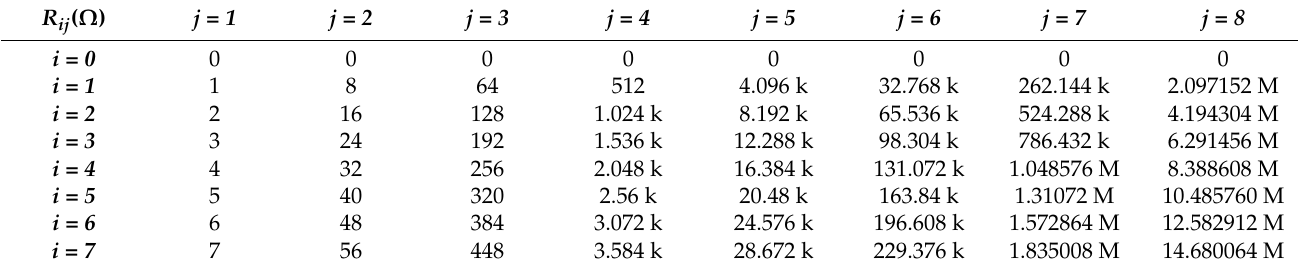
Table 1. R ij theoretical resistance values.